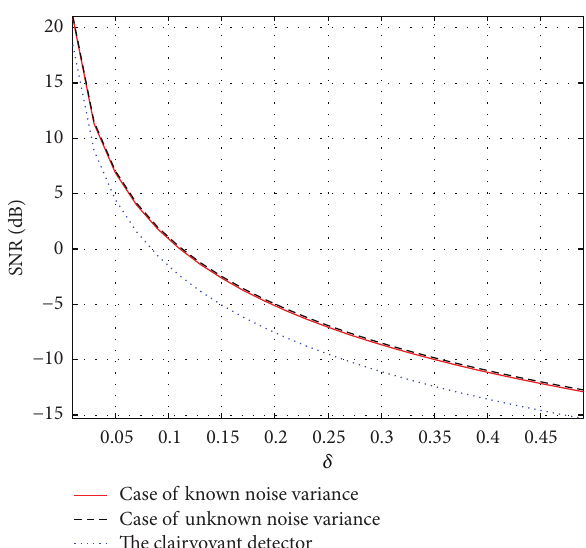
Figure 3: The SRL versus the resolution